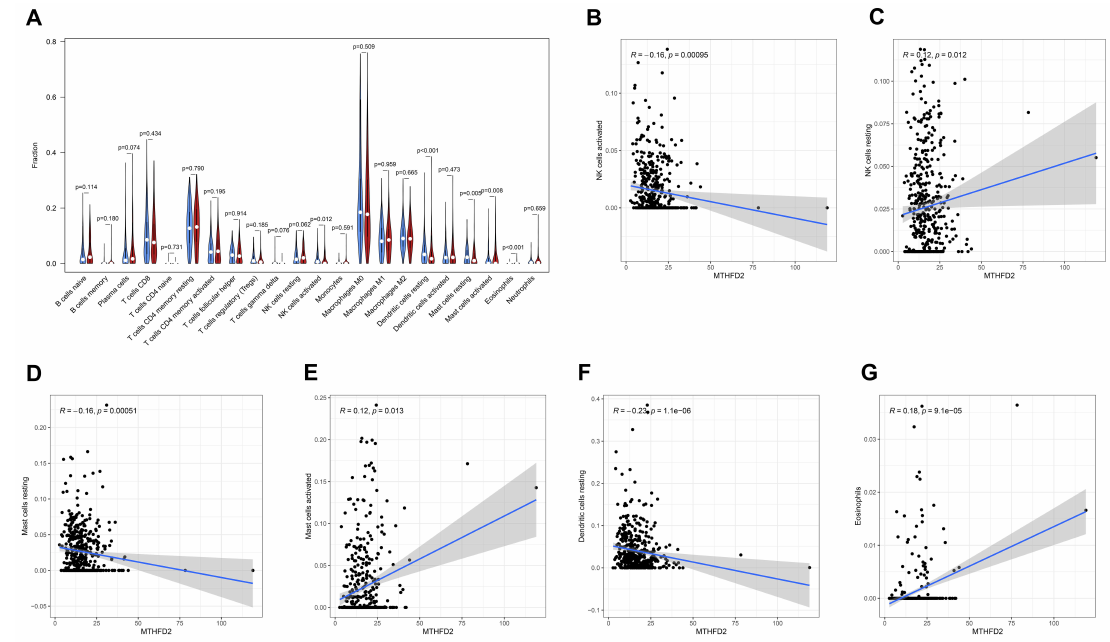
Figure 4. The association between MTHFD2 and immune cell infiltration in HNSCC. ( A ) higher fractions of mast cells activated and eosinophils were observed in the high MTHFD2 expression group, while higher fractions of NK cells activated, dendritic cells resting, and mast cells resting were found in the low MTHFD2 expression group. ( B – G ) MTHFD2 was positively correlated with NK cells resting, mast cells activated, and eosinophils, while negatively associated with NK cells activated, mast cells resting, and dendritic cells